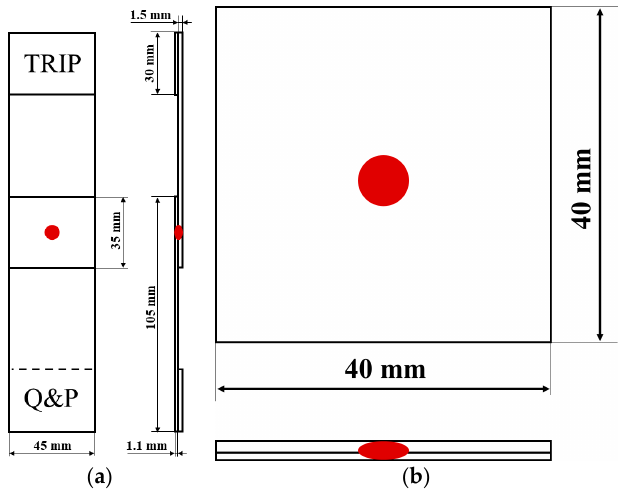
Figure 1. Size of the ( a ) lap shear and ( b ) salt spray specimens. The red spot represents the spot weld in the welded samples. Drawings not to scale.